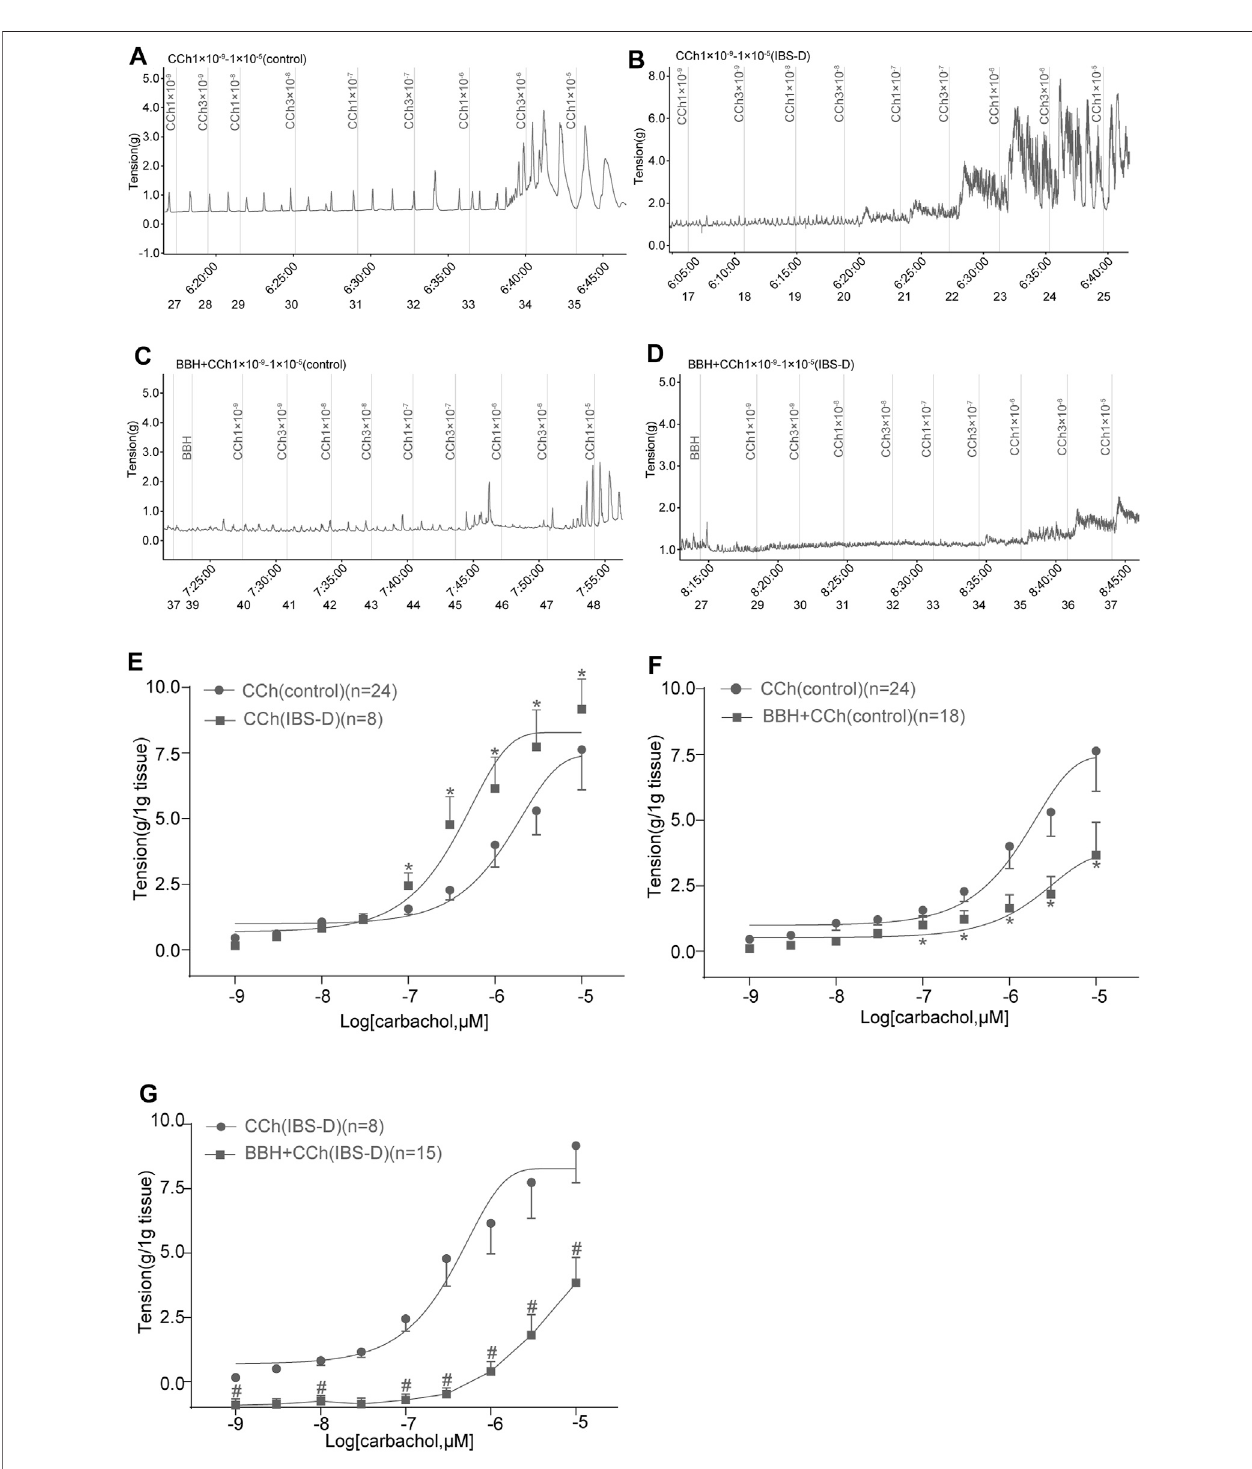
FIGURE 6 | BBH inhibited the cholinergic contractile responses of isolated colonic longitudinal smooth muscles. Mechanical recording (A – D) and cumulative log concentration – response curve (E – G) of the effect of CCh and BBH + CCh treatments on the contractions of isolated colonic longitudinal smooth muscles in the control and IBS-D groups. (A) : CCh-induced control group ( n (cid:2) 24). (B) : BBH + CCh-induced control group ( n (cid:2) 18). (C) : CCh-induced IBS-D group ( n (cid:2) 8). (D) : BBH + CCh- induced IBS-D group ( n (cid:2) 15). (E) : Cholinergic contractile responses in the control and IBS-D groups. The EC 50 obtained in the IBS-D group was 0.4906 μ mol/L, whereas that in the control group was 2.527 μ mol/L * denotes p < 0.05 compared with the CCh-induced control group. (F) : BBH inhibited the cholinergic contractile responsesinthe control group. *denotes p < 0.05 compared withtheCCh-inducedcontrolgroup. (G) :BBH inhibited thecholinergiccontractileresponsesinthe IBS-D group. # denotes p < 0.05 compared with the CCh-induced IBS-D group. Error bars represent mean ± SEM.